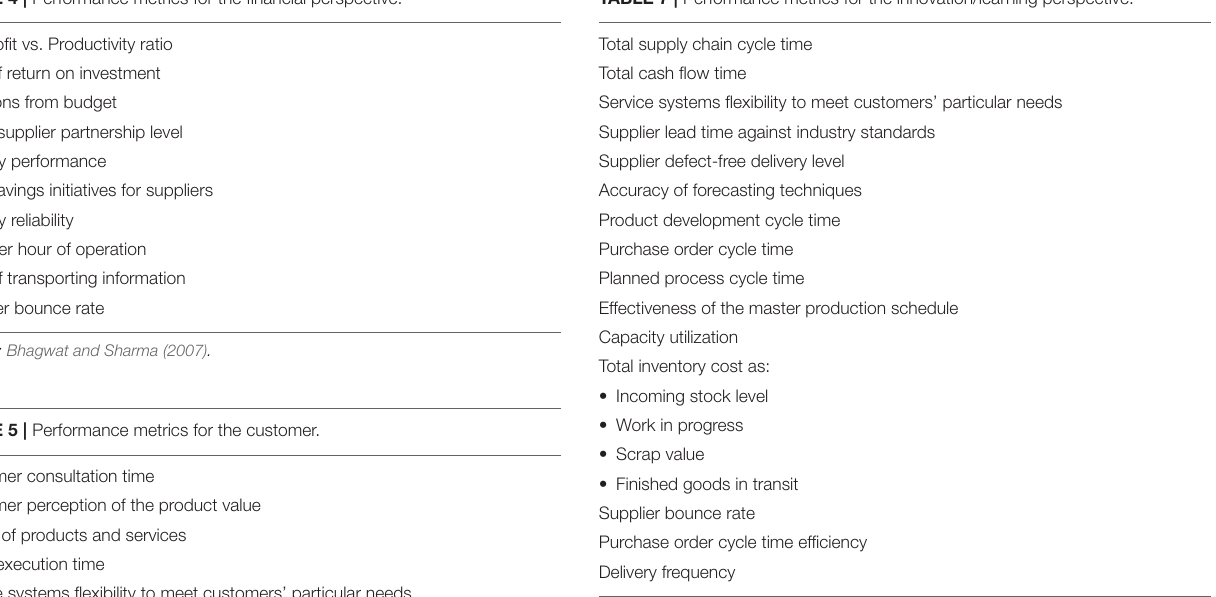
TABLE 7 | Performance metrics for the innovation/learning